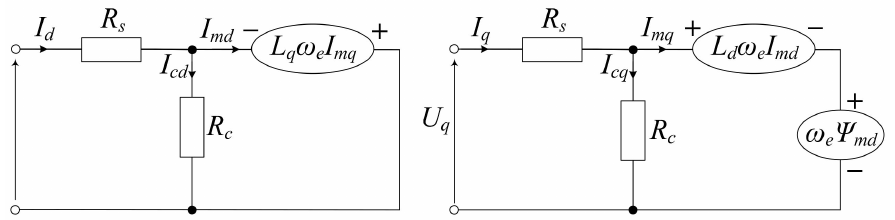
Figure 4. Applied steady-state model of PMSM in d-q reference